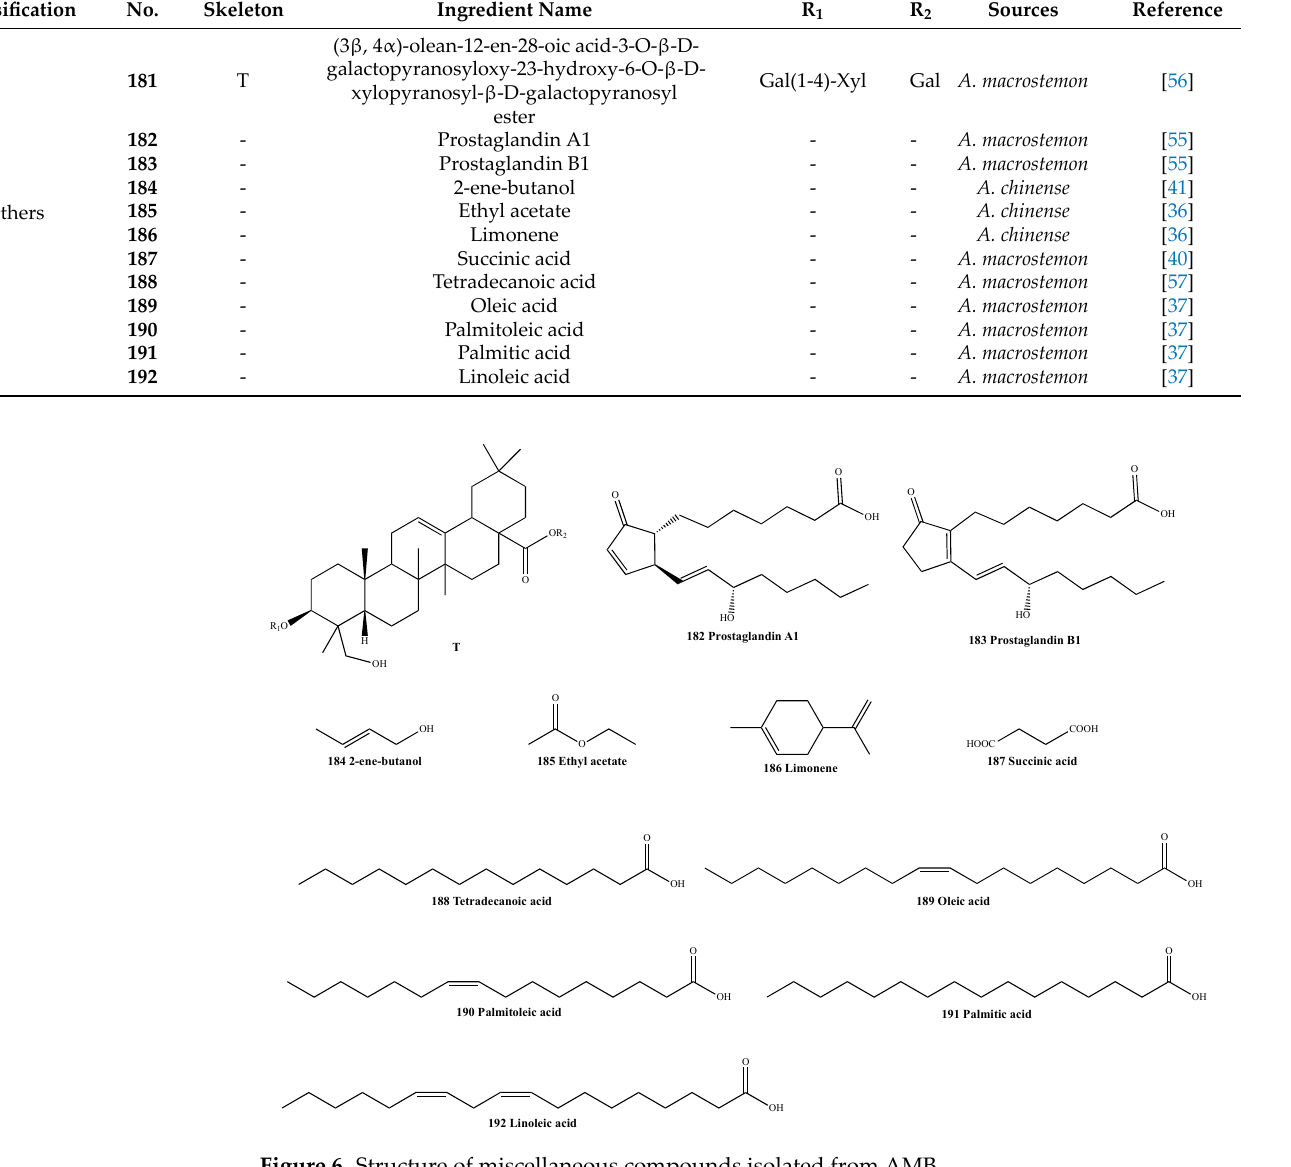
Figure 6. Structure of miscellaneous compounds isolated from AMB.